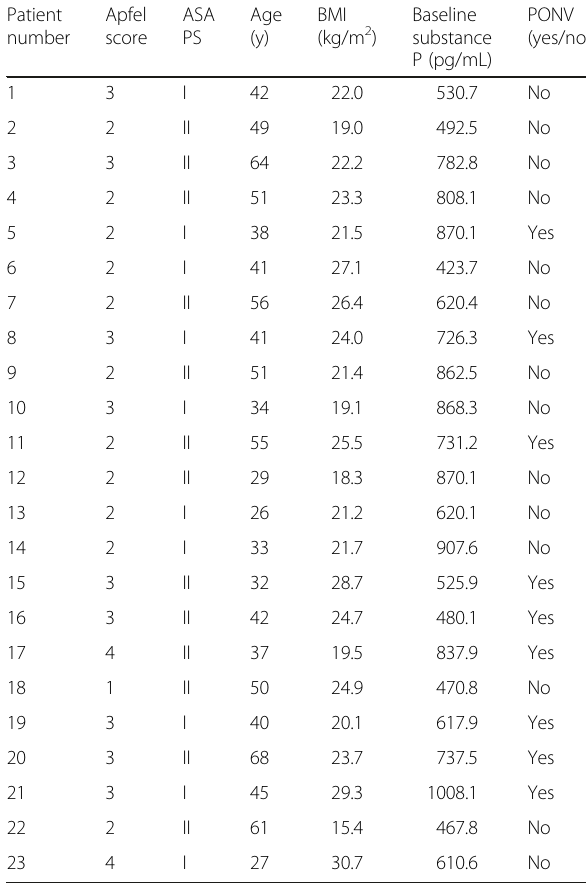
Table 1 Patient characteristics and individual